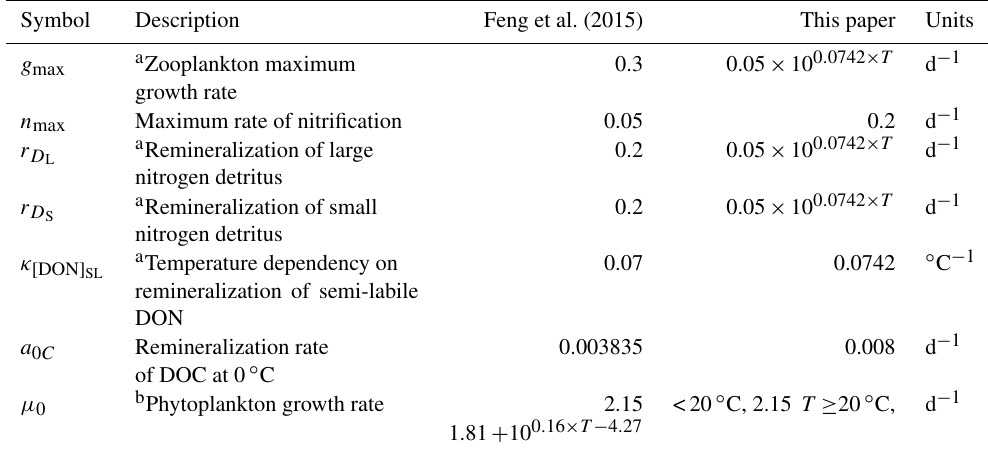
Table A2. Modifications to formulations and parameter values from Feng et al. (2015).